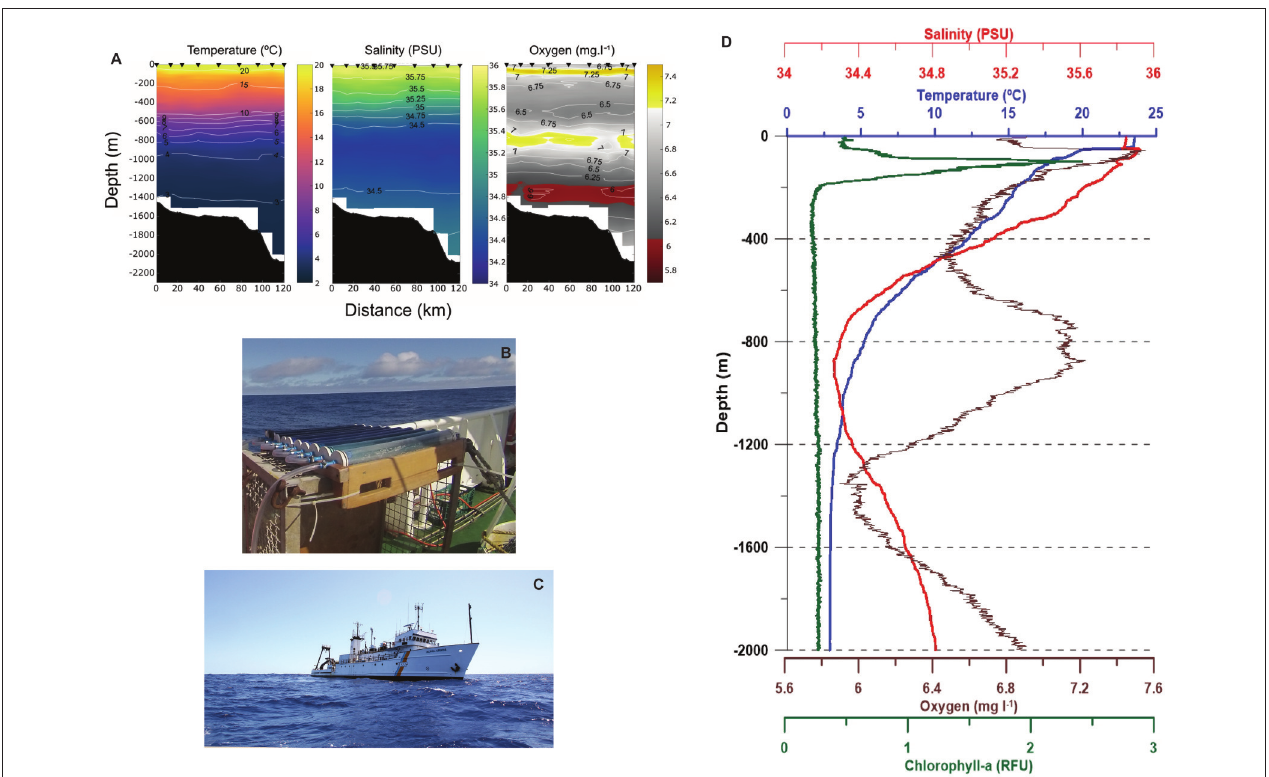
FIGURE 4 | (A) Water column temperature ( ◦ C), Salinity (PSU), and Dissolved Oxygen (mg L − 1 ) section for the CTD transect along the central rift, (B) In-situ simulated primary production experiment, (C) RV Alpha Crucis from the Instituto Oceanográfico da Universidade de São Paulo, and (D) CTD water column profiles of salinity (PSU), temperature ( ◦ C), dissolved oxygen (mg L − 1 ), and chlorophyll-a (RFU).